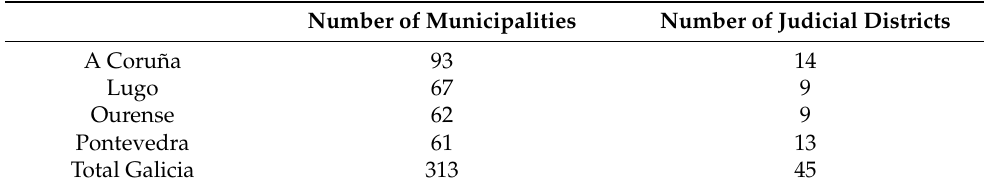
Table 1. Distribution in Galicia and provinces of the number of municipalities and judicial